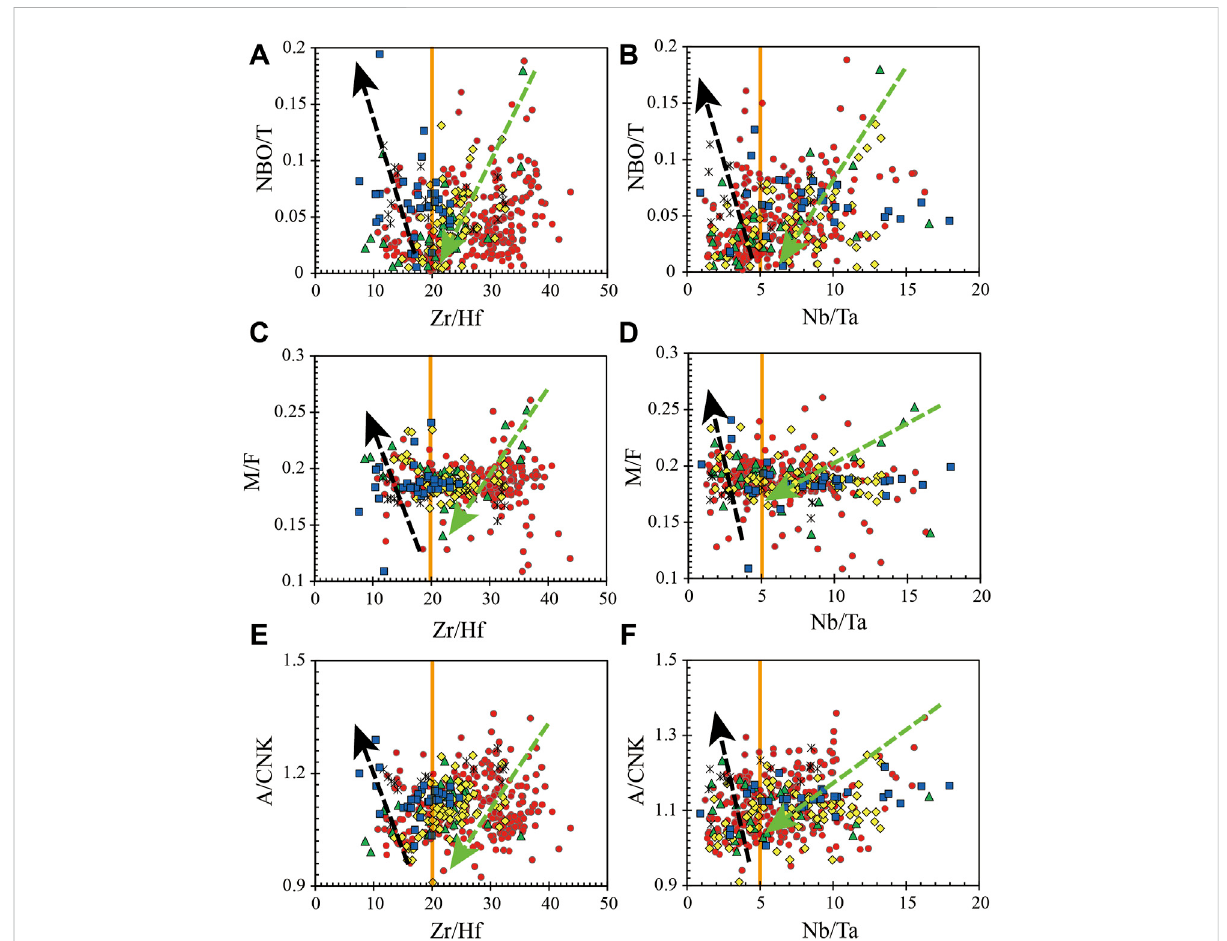
FIGURE 4 Relationship between the textural change in the silica melts (represented by NBO/T, M/F, and A/CNK) and high- fi eld strength elements ’ ratios (Zr/Hf and Nb/Ta). NBO/T is the ratio of non-bridging oxygen (NBO) atoms to silicon (Si) atoms. NBO/T = (2 × A – 4 × T)/T, where A = O 2- + H 2